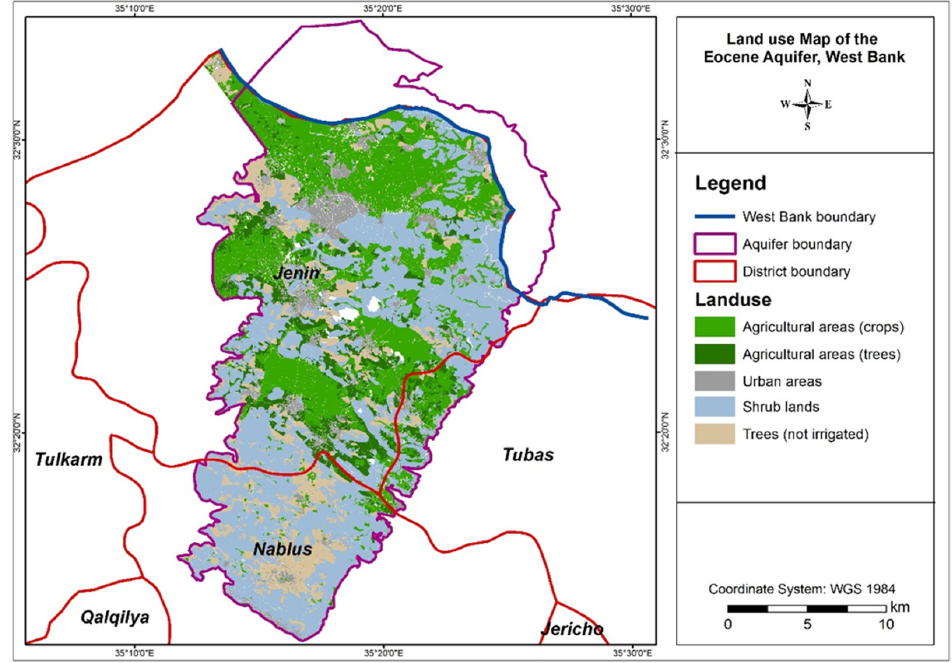
Figure 3. Land use map for the Eocene aquifer area.